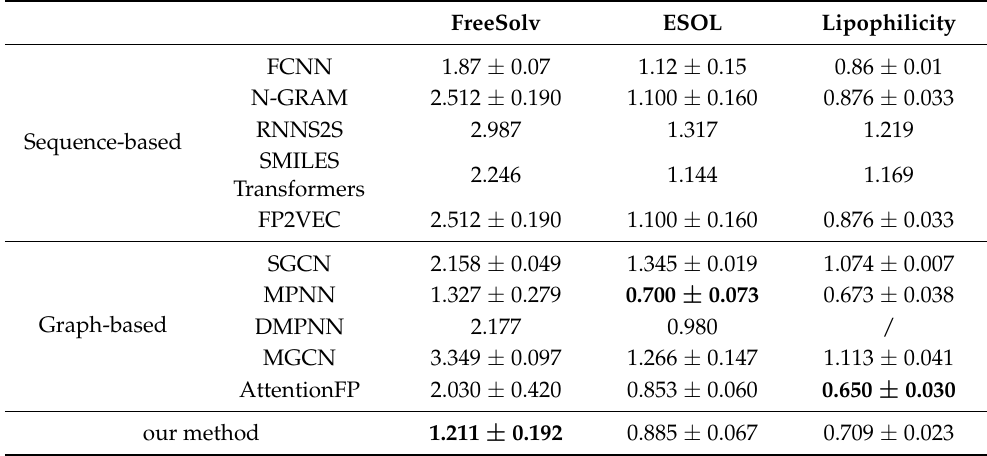
Table 3. RMSE scores of regression tasks on test sets. The values in boldface represent the best prediction performances with the corresponding datasets.